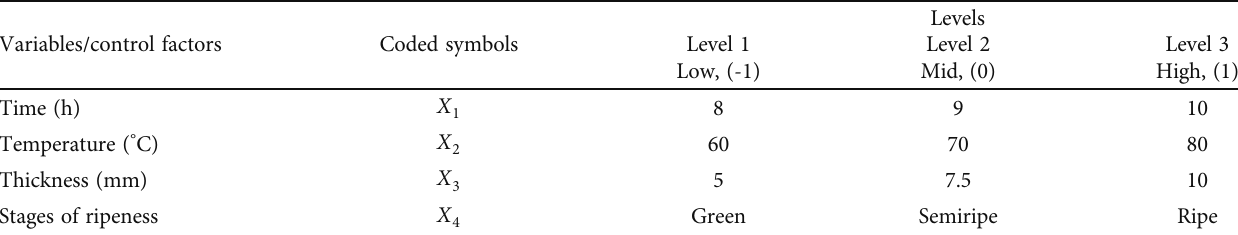
Table 1: Level of control